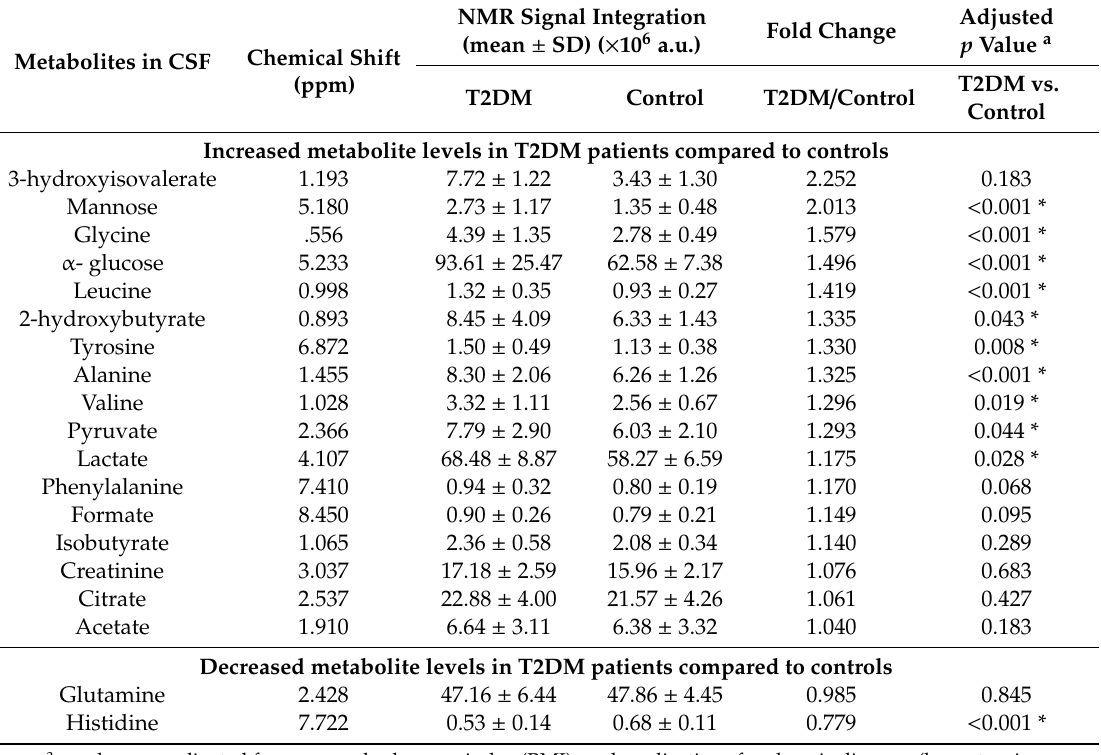
Table 2. Metabolites changed in CSF samples from T2DM patients versus control subjects.